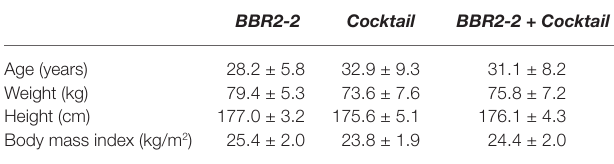
TABLE 1 | Participant demographics at